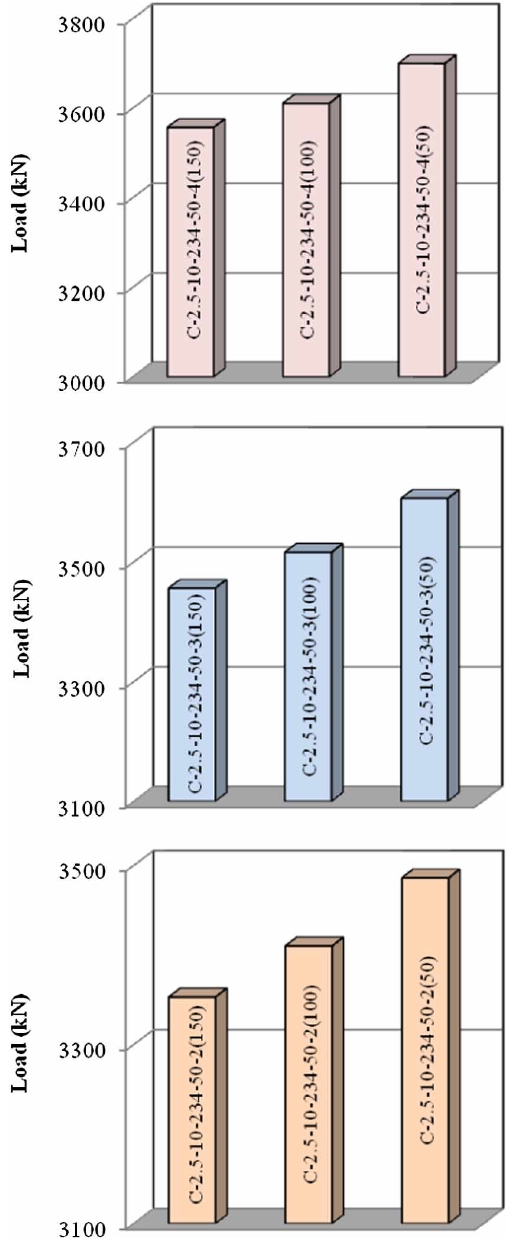
Fig. 10. Effects of spacing of bar stiffeners on ultimate axial load